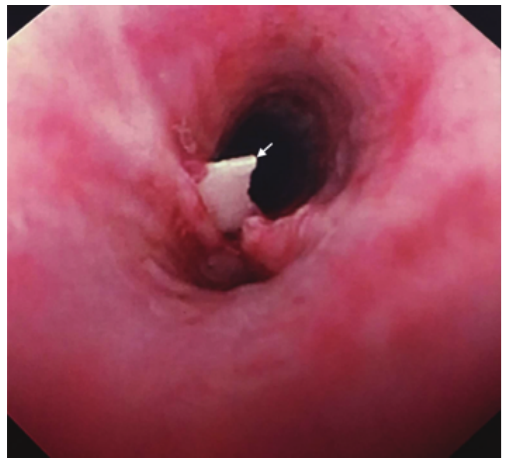
Figure 2: Bronchoscopy revealing rupture of cartilage at subcarina of medial segment of right middle lobe. There was no evidence of endobronchial mass or extrinsic